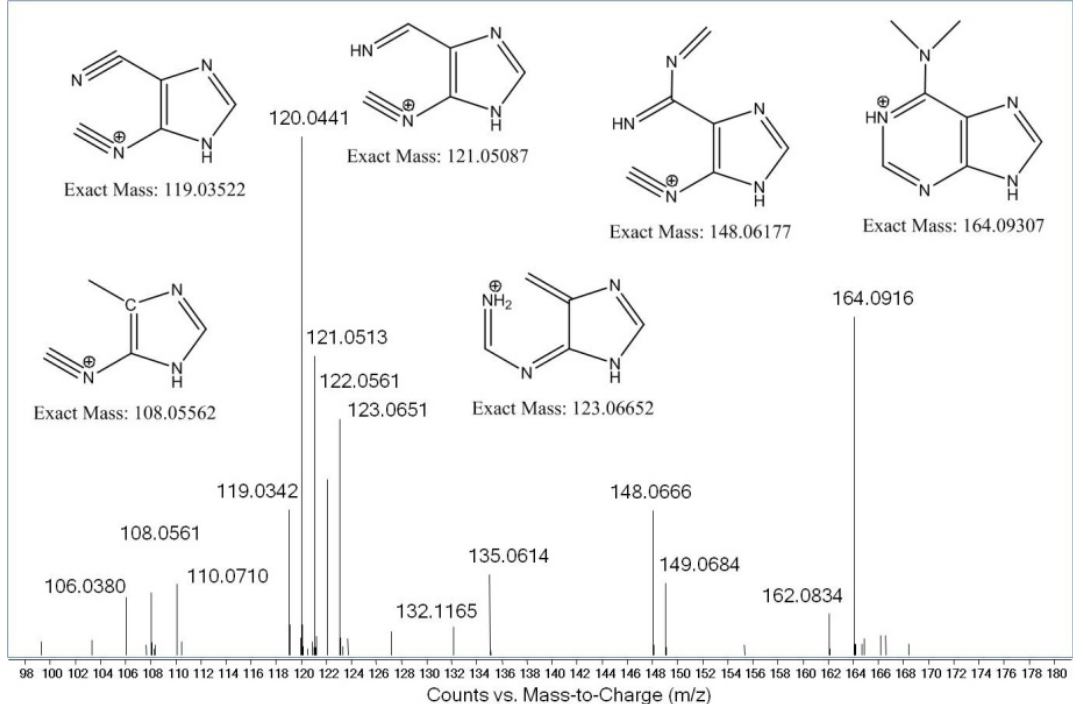
Figure 4. Pseudo-MS 3 fragmentation of m/z 164.0924 derived from the m/z 296.1350 ribonucleoside. Tentative structures of fragment ions are based on a model proposed by Nelson and McCloskey [18].